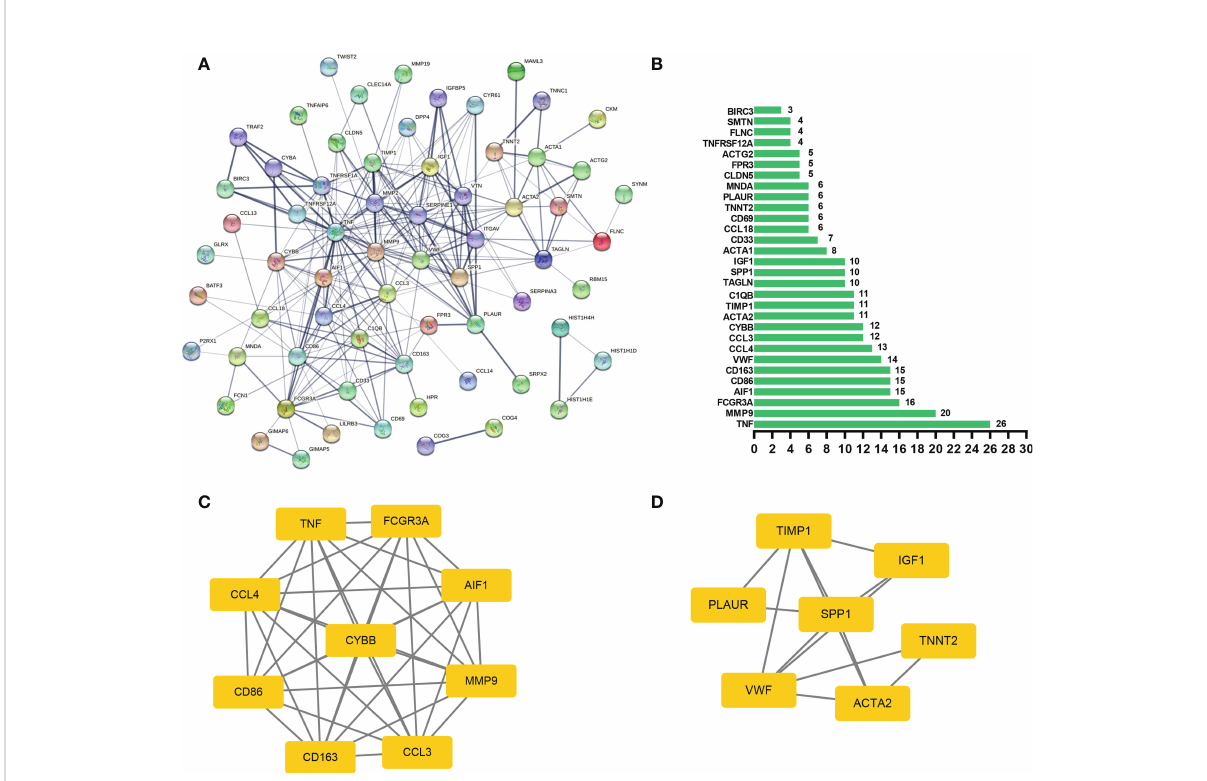
FIGURE 5 PPI network analysis. (A) The PPI network of genes of the key modules identi fi ed via WGCNA, and the bigger sizes of edges mean the higher degree. (B) The top 30 genes of the most connexity in the PPI network. (C) The fi rst module of the PPI network. (D) The second module of the PPI